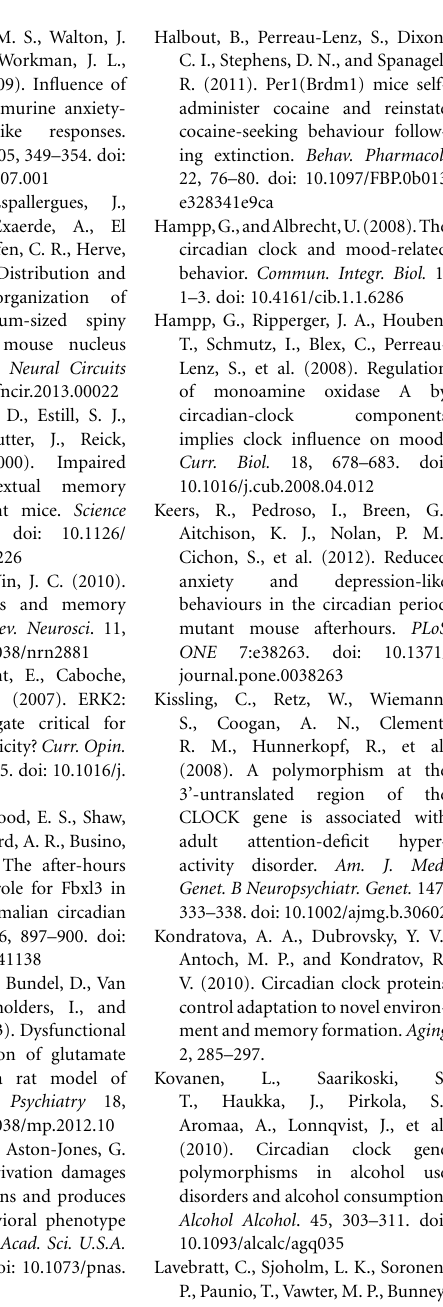
Figure S2 | Motor coordination and learning in Cry1 − / − Cry2 − / − mice. (A) Curve showing coordination and motor learning in WT ( n = 16), Cry1 − / − Cry2 + / + ( n = 5), Cry1 + / + Cry2 − / − ( n = 6) and Cry1 − / − Cry2 − / − ( n = 8) mice over a training period of 3 days. Data (means ± sem) were analyzed using Two-Way ANOVA repeated measures [Time × Genotype: F ( 6 , 62 ) = 0 . 1692, P = 0 . 7813; Time: F ( 2 , 62 ) = 57 . 44, P < 0 . 0001; Genotype: F ( 3 , 31 ) = 22 . 40, P < 0 . 0001]. ( ∗∗∗ p < 0 . 001 mutant mice vs. WT mice). (B) Percentage of learning in WT ( n = 16), Cry1 − / − Cry2 + / + ( n = 5), Cry1 + / + Cry2 − / − ( n = 6) and Cry1 − / − Cry2 − / − ( n = 8) Data (means ± sem) were analyzed using Two-Way ANOVA repeated measures [Time × Genotype: F ( 3 , 31 ) = 2 . 034, P = 0 . 1294; Time: F ( 1 , 31 ) = 113 . 8, P < 0 . 0001; Genotype: F ( 3 , 31 ) = 0 . 9203, P = 0 . 4425]. ( ∗∗∗ p < 0 . 001 Day 1 vs. Day 3).